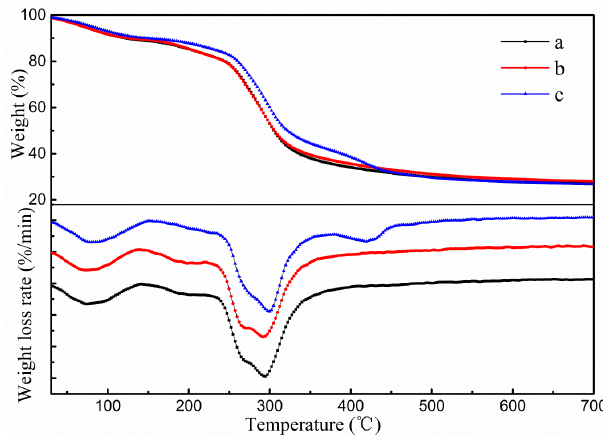
Figure 3. TG–DTG graphs of different samples. ( a ) Control; ( b ) 3% TiO 2 -N; and ( c ) 9% CO-3% TiO 2 - N.